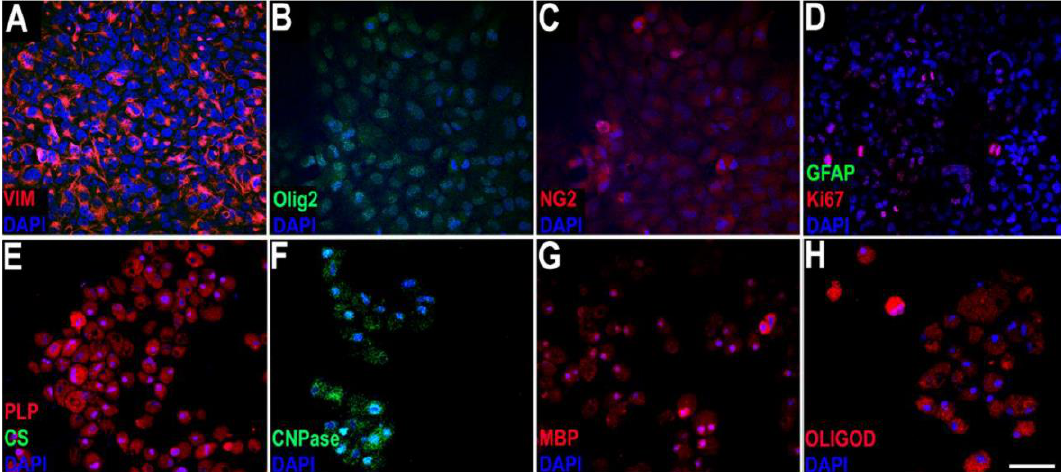
Figure 1. Immunofluorescence photomicrograph showing the expression of oligodendroglial lineage cell markers. ( A – G ): immunocytochemical staining for vimentin ( A ), Olig2 ( B ), NG2 ( C ), GFAP + Ki67 ( D ), PLP + glutamine synthetase ( E ), CNPase ( F ), MBP ( G ) and Oligodendrocytes ( H ). Scale bar: 50 µm.